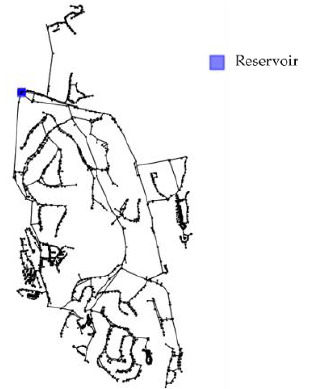
Figure 5. Layout of the case study.